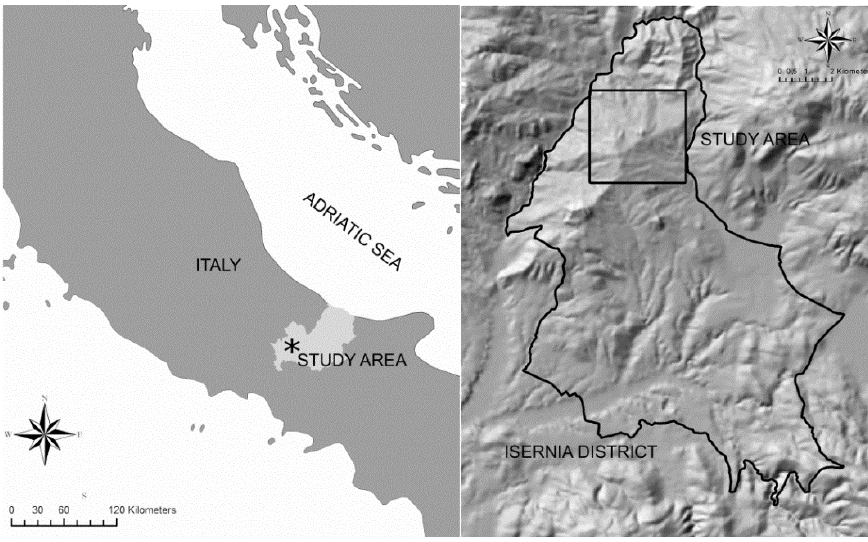
Figure 1. Map showing the Isernia district (Italy) and the location of the study